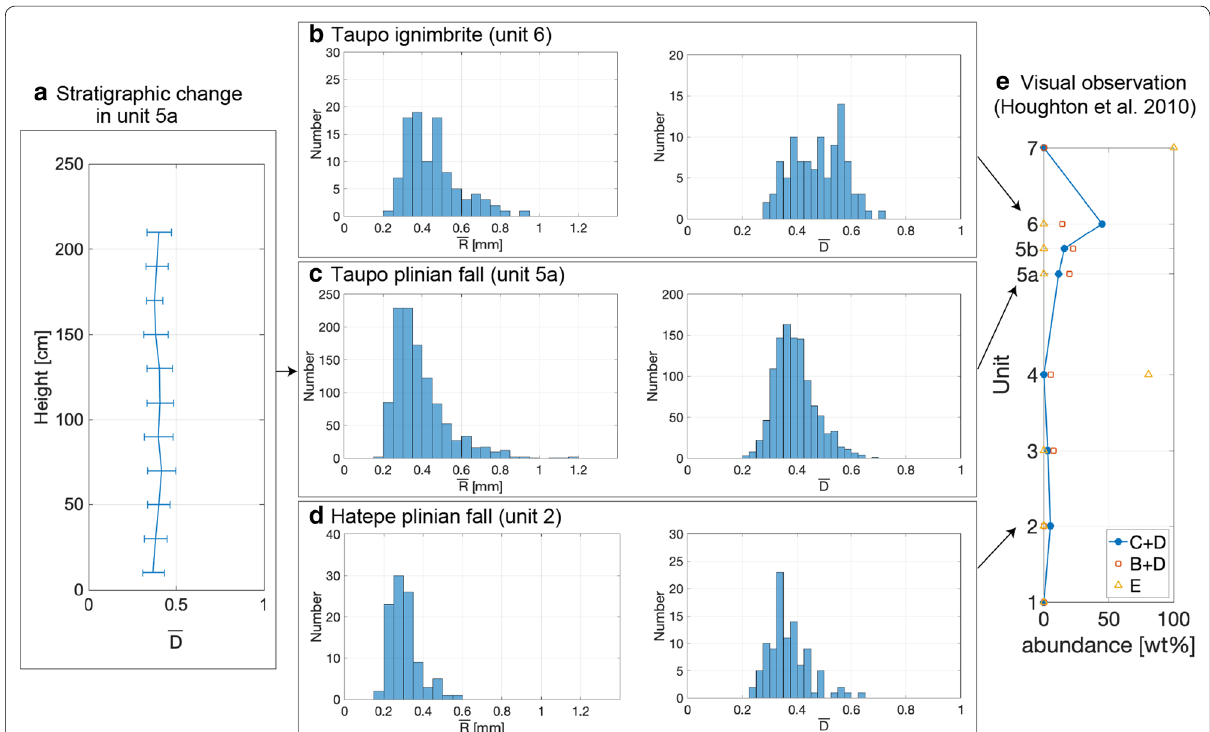
Fig. 9 Stratigraphic change of bubble textures. a The vertical variation of mean D in unit 5a with error bars indicating the standard deviation. b – d Histograms of the average bubble radius R and the average bubble deformation degree D for Taupo ignimbrite, Taupo plinian fall, and Hatepe plinian fall. e The abundance of clast types visually judged by Houghton et al. (2010) (B: coarsely vesicular pumice dominated by spherical bubbles, C: long-tube microvesicular pumice with elongate bubbles, D: long-tube coarsely vesicular pumice with elongate bubbles, E: gray and dense material)